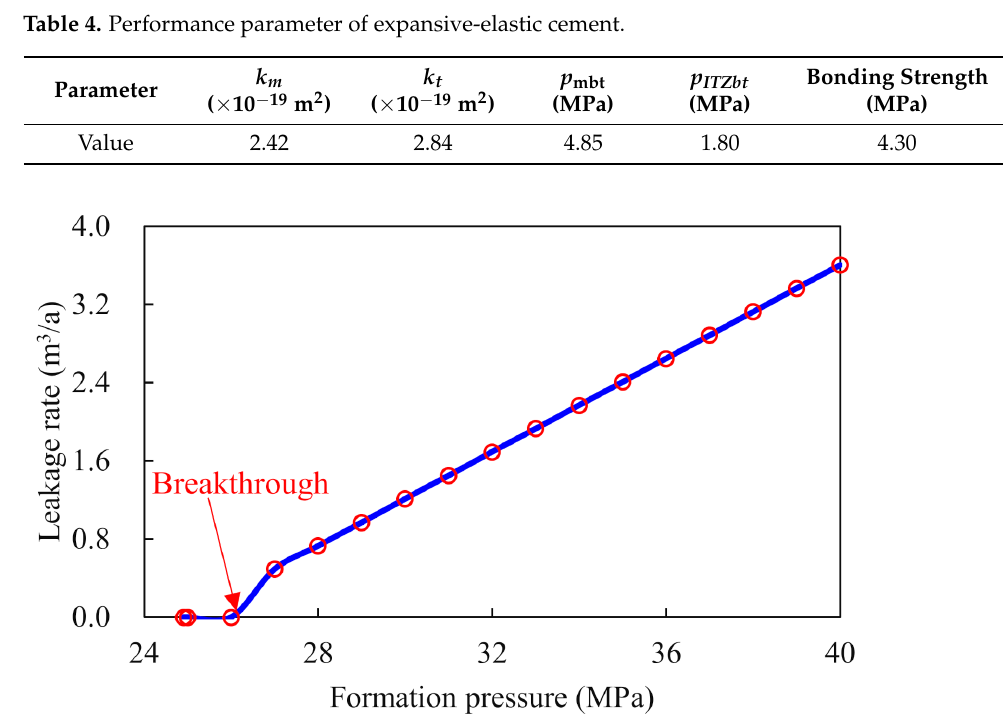
Figure 8. The relationship between leakage rate and formation